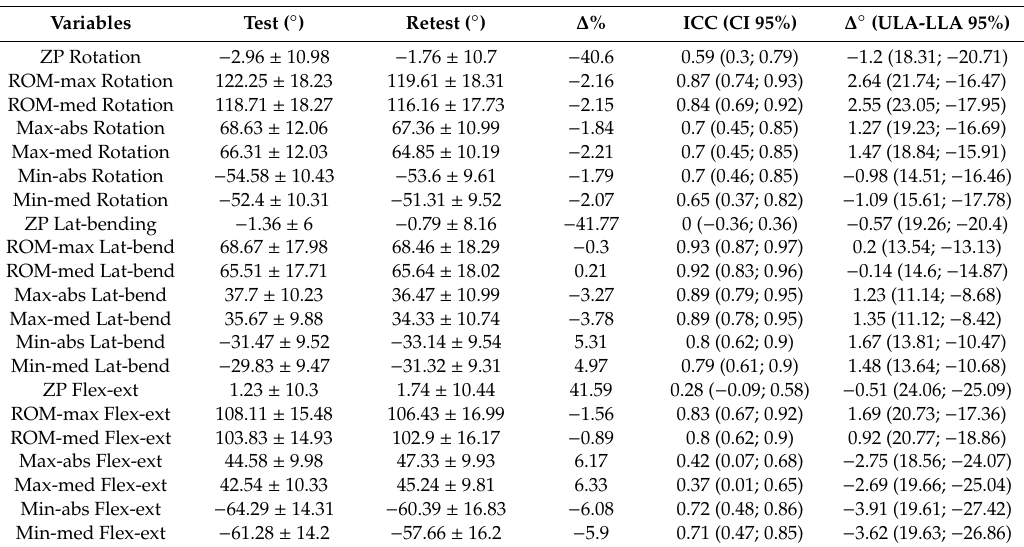
Table 3. Results for elderly